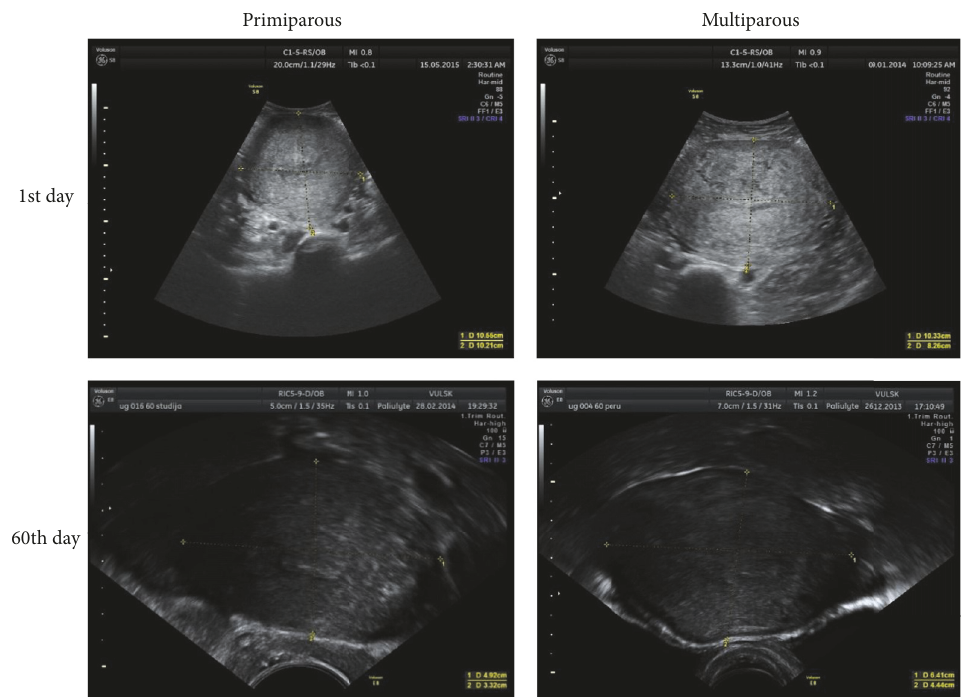
Figure 3: Uterus width measurements in transverse